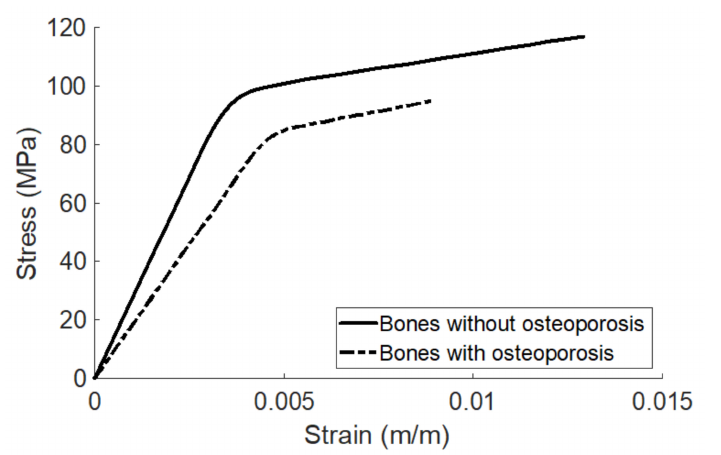
Figure 6. The stress–strain curves of bones with and without osteoporosis. This figure is adapted from Figure 4 in